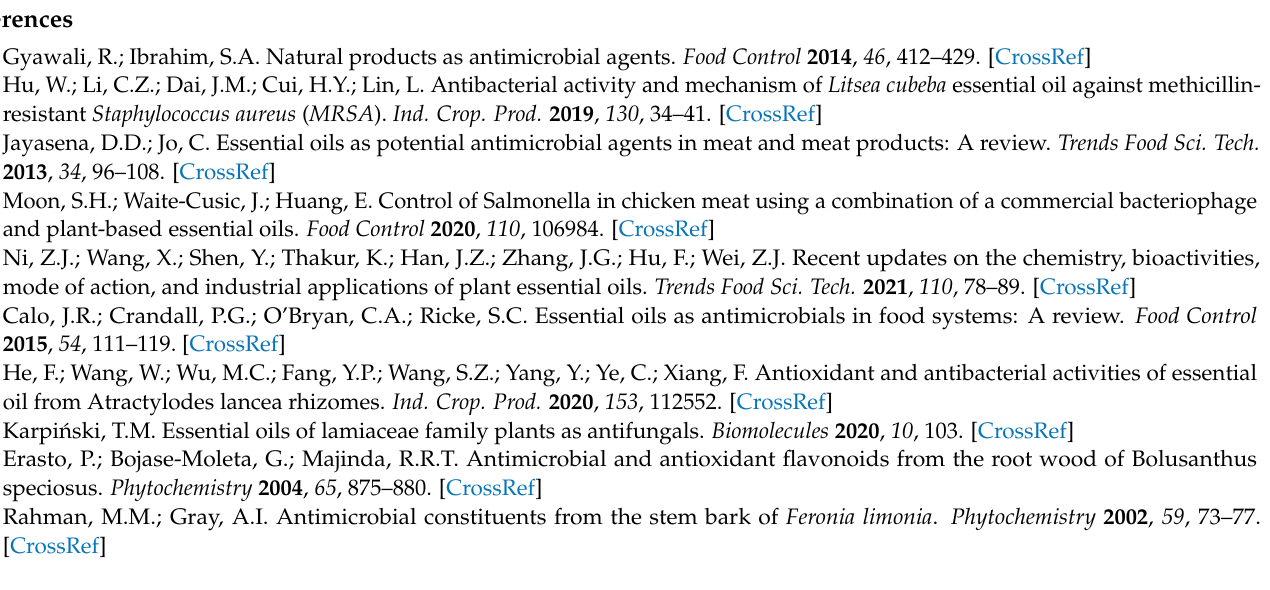
CAR, Table S1: Effects of preparation parameters on antibacterial activities of ZnO/PAL against E. coli , Table S2: The MIC values of PEOs/ZnO/PAL nanocomposites against E. coli and S. aureus , Table S3: The MIC values of PAL and ZnO/PAL at different concentrations of CAR against E. coli